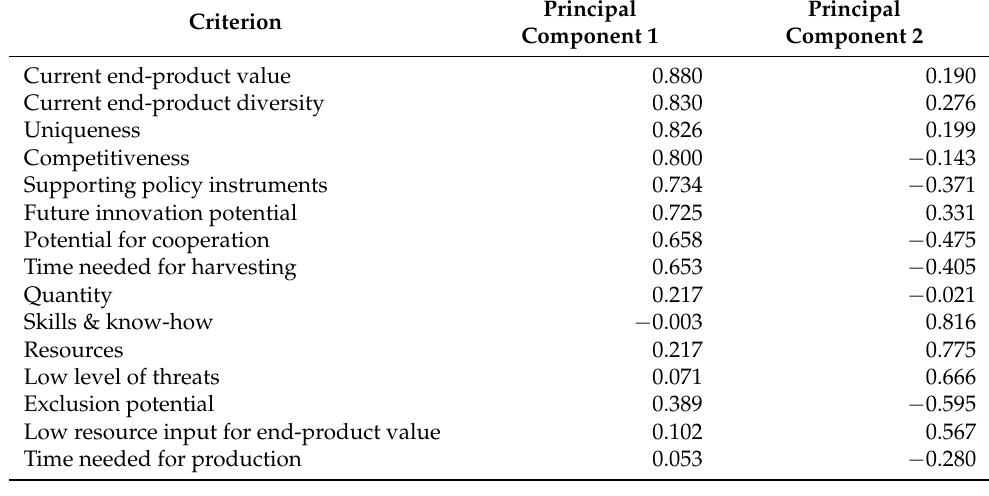
Table 6. Rotated component matrix indicating the loadings of principal components 1 and 2 per criterion.